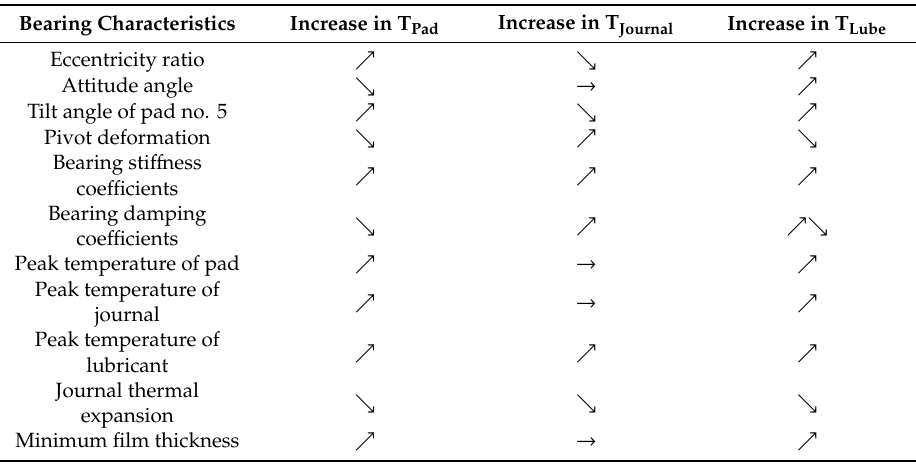
Table 6. E ff ect of thermal boundary condition on tilting pad journal bearing